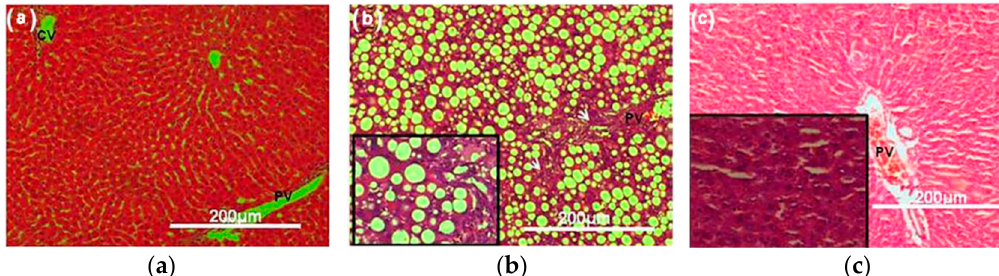
Figure 3. Liver histopathological changes in different experimental animals. ( a ) Normal group, ( b ) rats supplemented with a methionine-choline deficient diet, ( c ) rats receiving the germinated mung bean (1000 mg/kg body weight, for 4 weeks) and supplemented with a methionine-choline deficient diet. Scale bar, 200 μ m; White arrow: Fibrosis. Central vein (CV); portal vein (PV) [90].